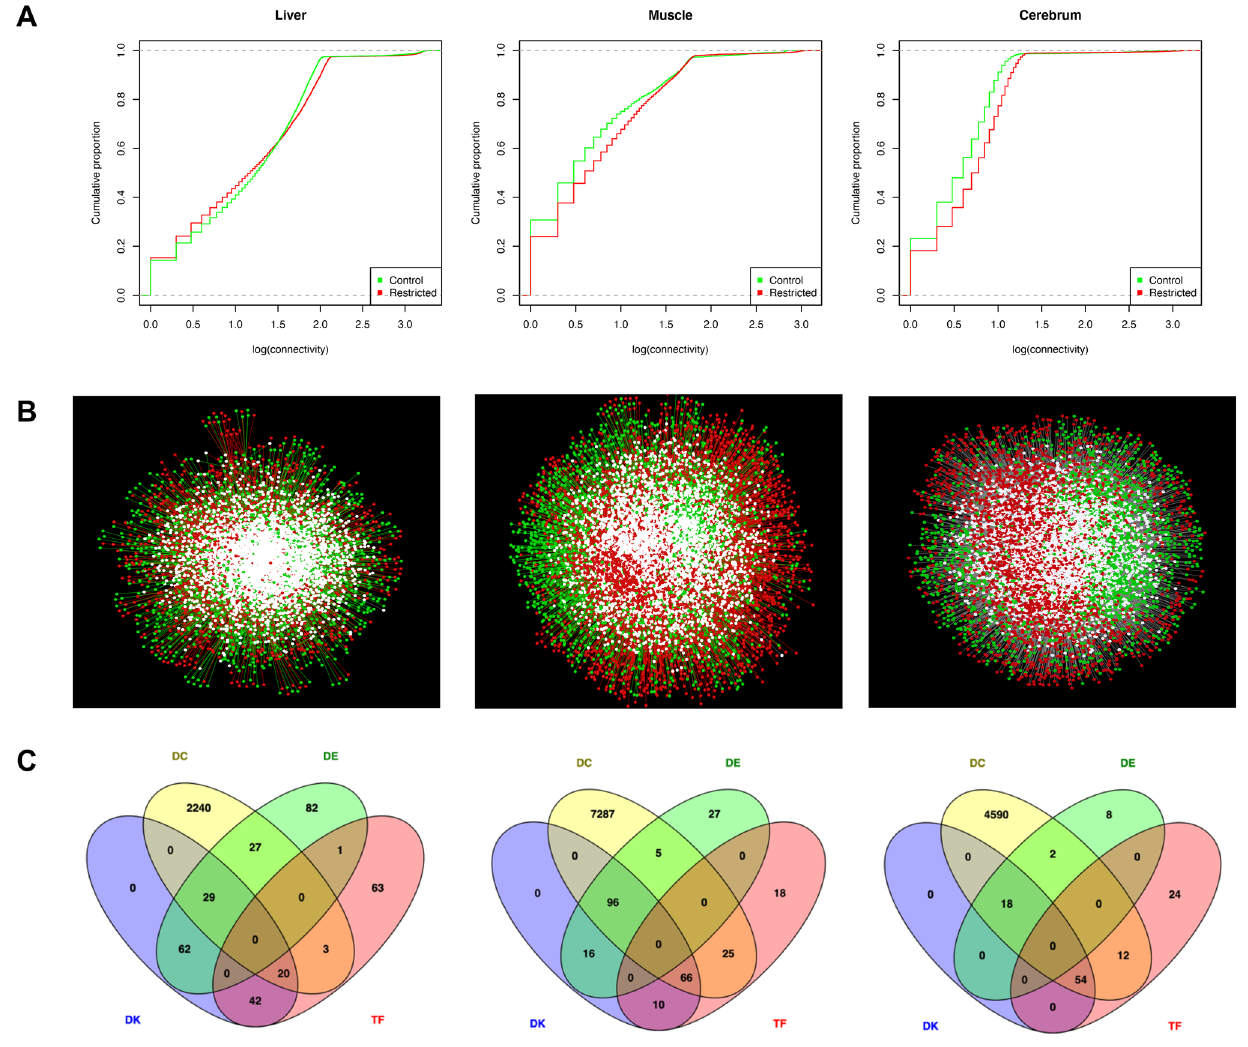
Figure 6. Network topology of co-expressed genes between control and nutrient restricted fetuses from the liver, muscle, and cerebrum tissues in bovine. ( A ) Cumulative distribution functions of the gene connectivity. ( B ) Central reference union networks. Only those gene pairs assigned as DEG or TF are shown. Unique nodes are shown in green (control) or red (restricted). Shared nodes are shown in white; ( C ) Overlapping genes among the different analyses. TF—transcription factors; DE – differentially expressed gene; DC—differentially co-expressed; and DK—differentially connected. Cumulative distribution was created on R v.3.5.1 79 ; Gene network was created on Cytoscape v.3.7 89 ; and Venn diagram was created using Venny v.2.1. 94 (https ://rb.gy/ jxxuf